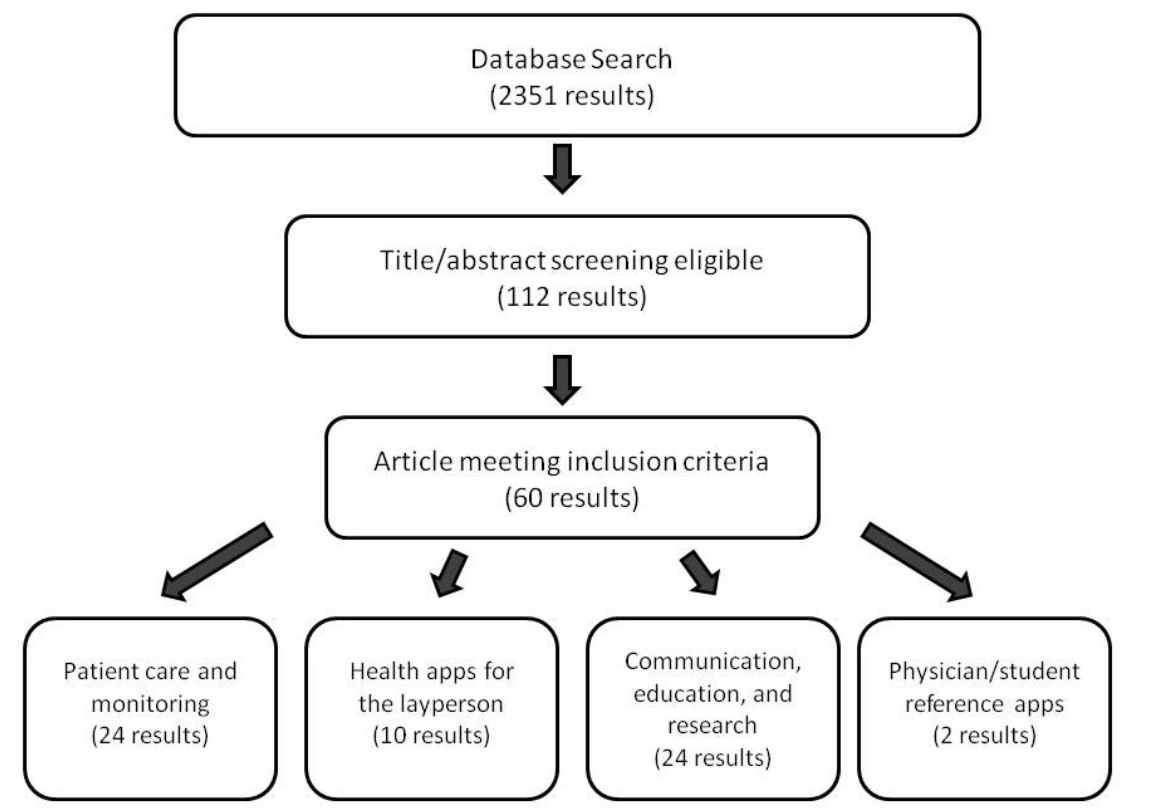
Figure 1. Flow diagram of the process of article selection and